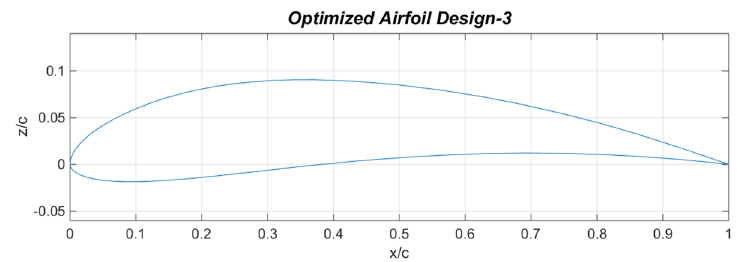
Figure 9. Optimized airfoil for Design-3.